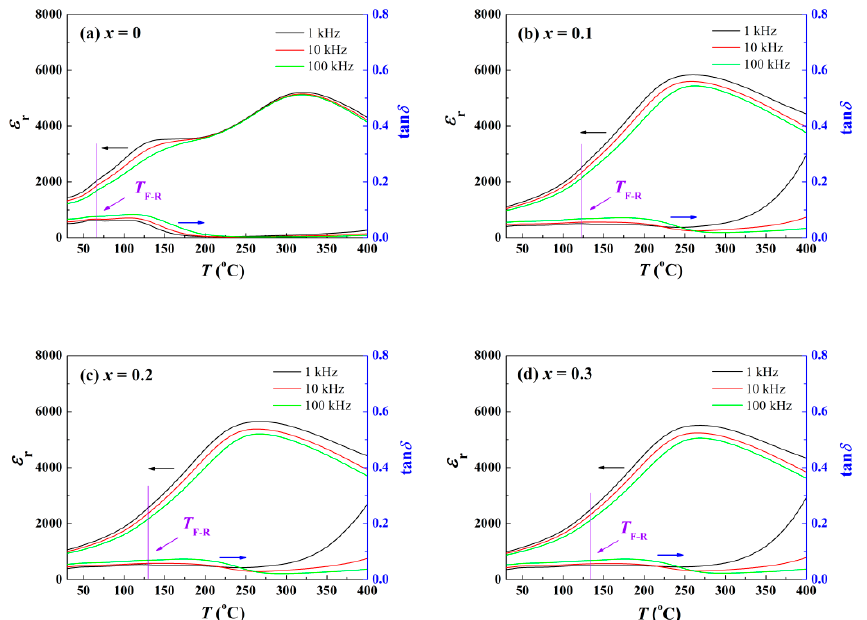
Figure 2. Elemental mapping on the surface of BNKT-BT-0.3ZnO composites, ( a ) morphology of scanning micro area, the distribution of ( b ) Bi, ( c ) Ba, ( d ) Ti, and ( e ) Zn.